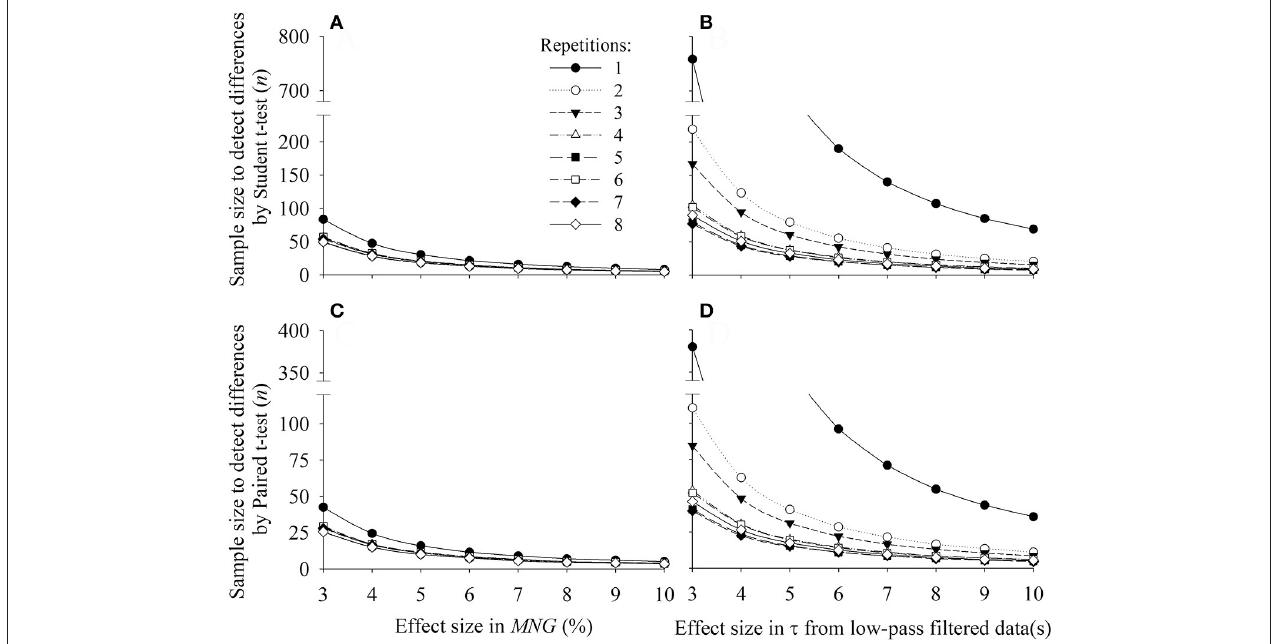
FIGURE 7 | Relationship between effect size of the mean normalized gain amplitude ( MNG ) or time constant from low-pass filtered data ( τ ) with the sample size needed to find statistical significance by student t -test (A,B) or paired t -test (C,D) considering different number of exercise repetitions (symbols). The desired power and the significance level considered for the sample size calculations were 0.8 and 0.05,